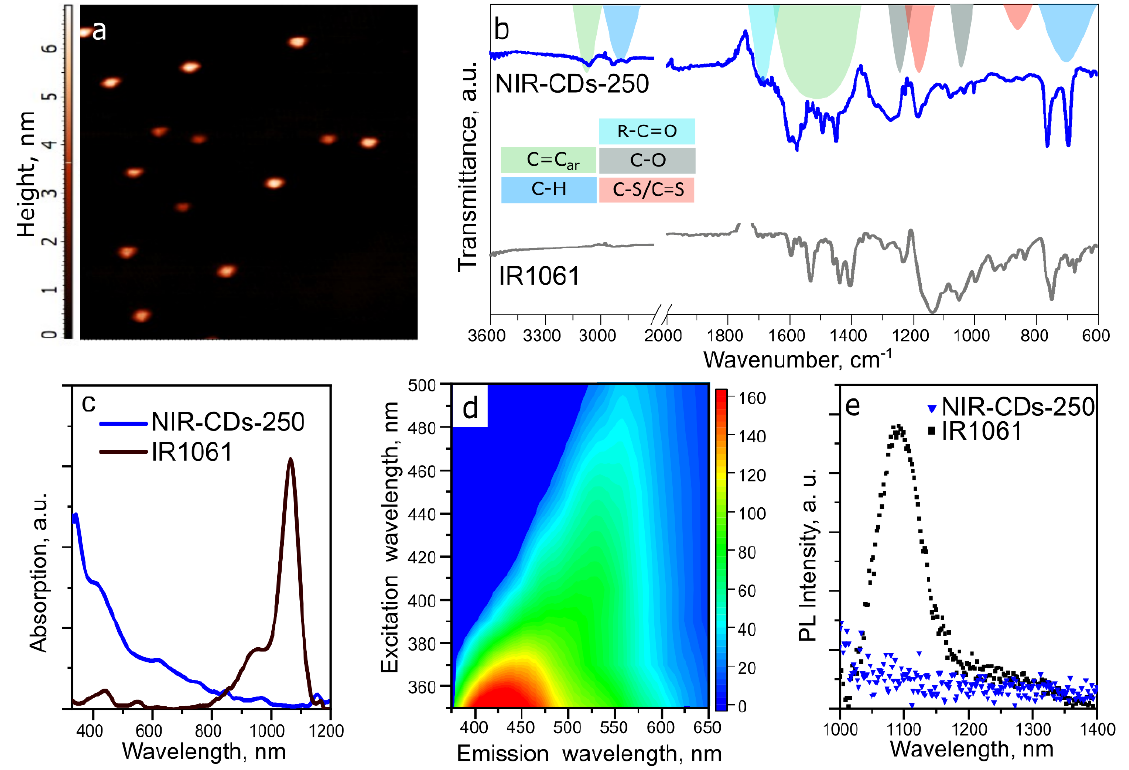
Figure 3. Morphology and optical properties of near infrared (NIR)-CDs-250. ( a ) AFM image (image size: 1.7 × 2 μm ). ( b ) FTIR and ( c ) absorption spectra, compared with those of the IR1061 precursor. ( d ) PLE-PL map. ( e ) Emission in the NIR spectral region from NIR-CD-250 in acetone, compared with emission of IR1061 in chloroform.